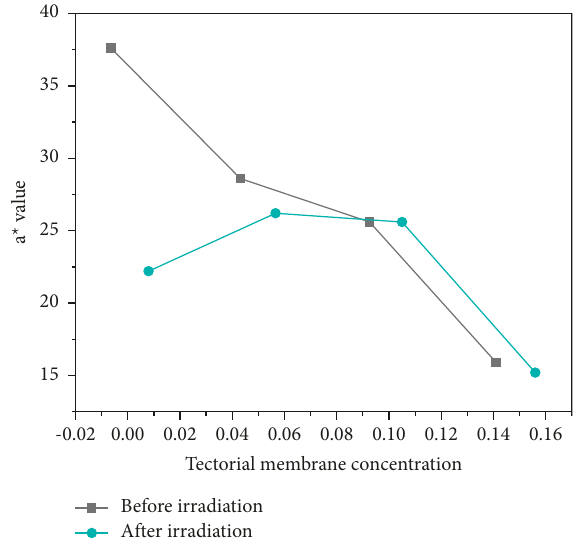
Figure 3: a ∗ value before and after the aging of samples coated with nano-TiO 2 film with different concentrations of silicon and aluminum.